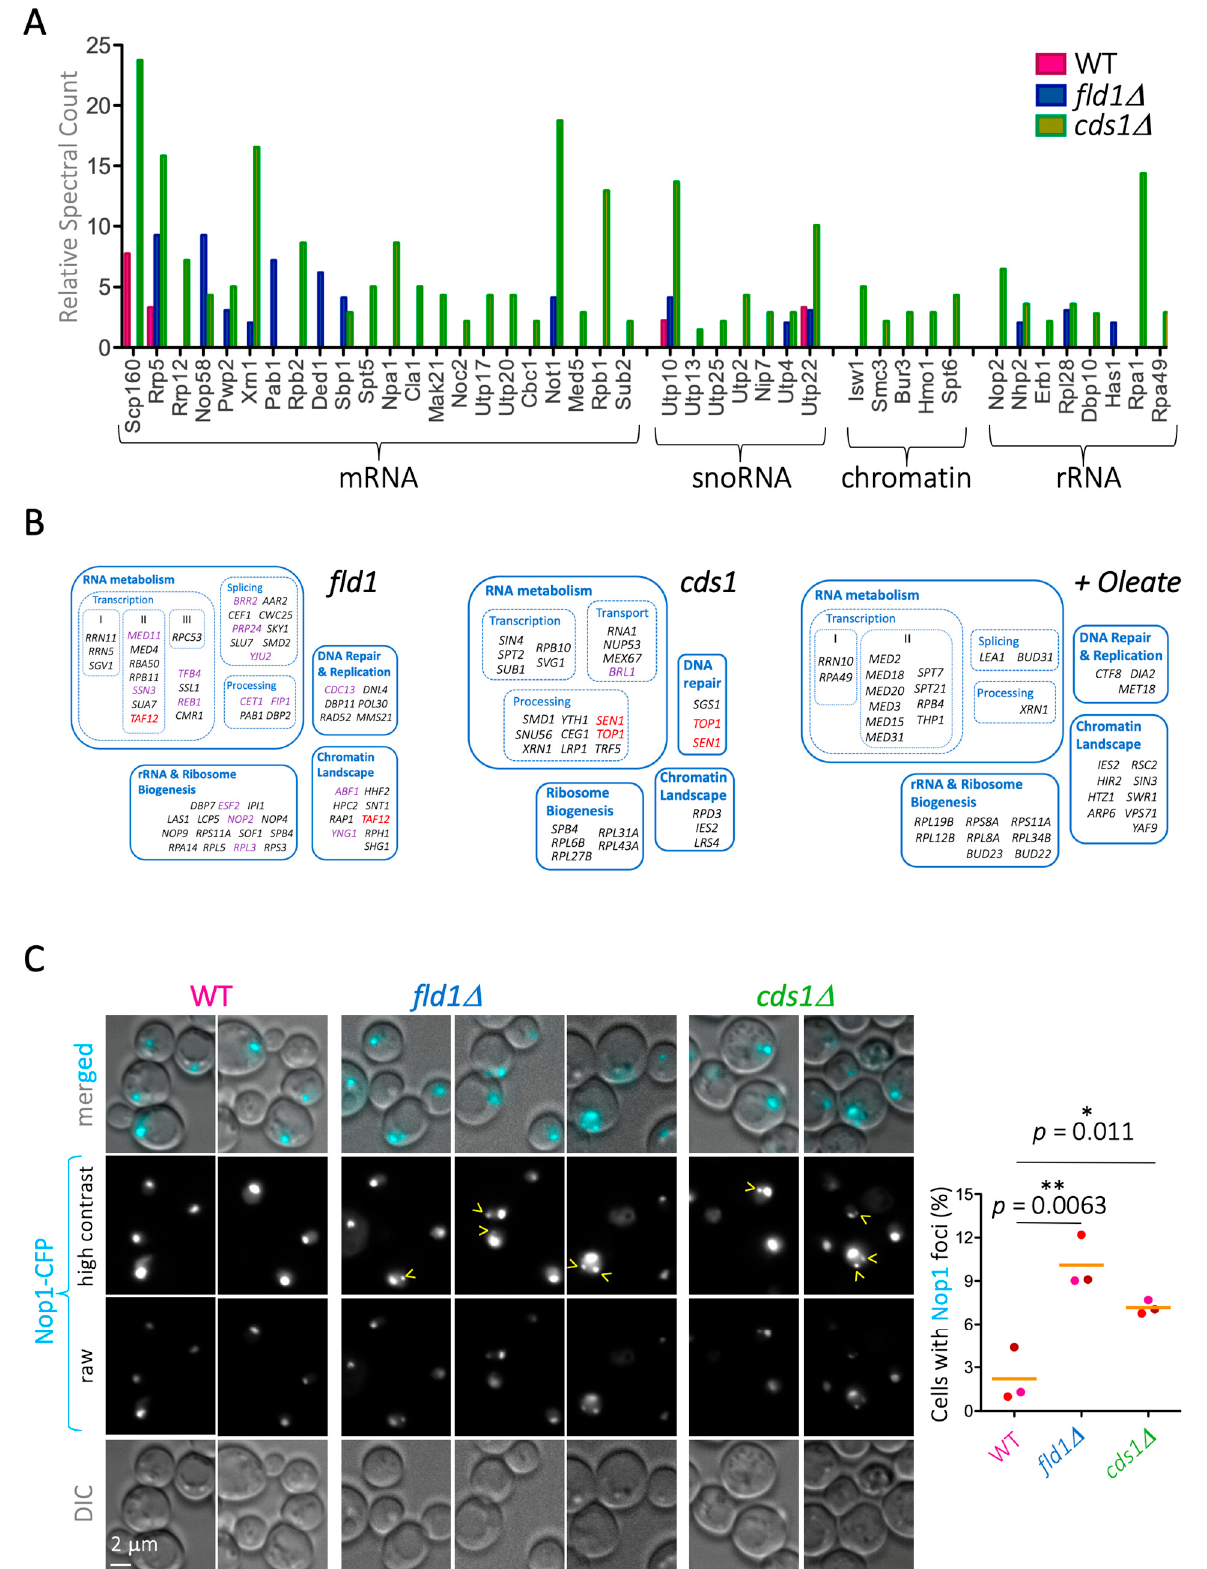
Figure 7. LD alterations predispose to genome instability. ( A ) Graphical representation of the relative presence of karyo- pherin cargoes found on the LD of WT, fld1 Δ , and cds1 Δ cells purified from saturated Saccharomyces cerevisiae cultures (original data reported in [31]). The hits are grouped by biological role. ( B ) The 257 genetic interactors of the fld1 mutation (left) and the 232 interactors of the cds1 mutation (center) were retrieved from the Saccharomyces Genome Database, while